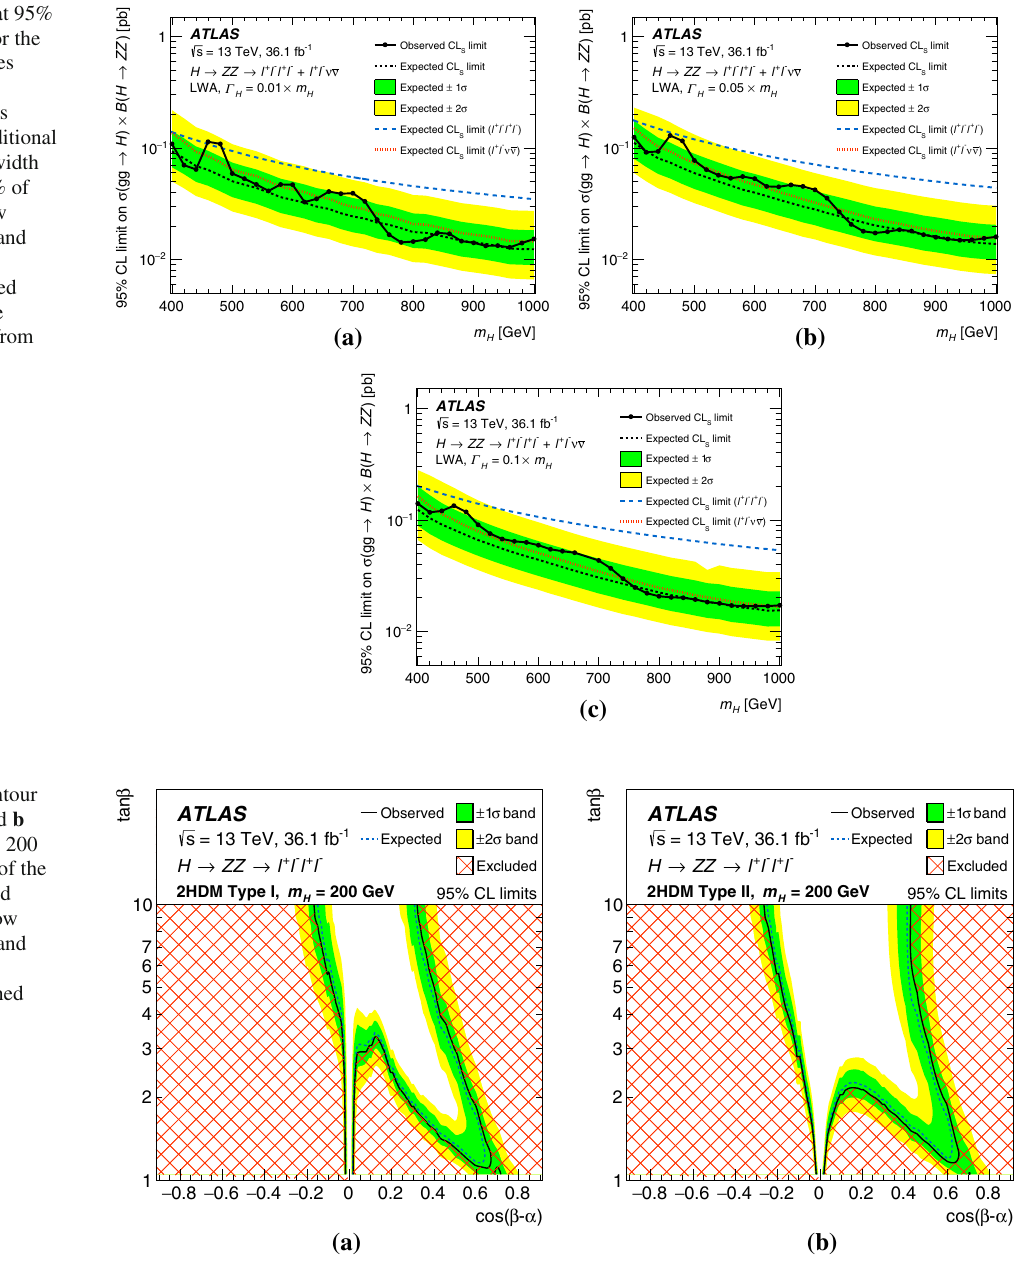
Fig. 8 The exclusion contour in the 2HDM a Type-I and b Type-II models for m H = 200 GeV shown as a function of the parameters cos (β − α) and tan β . The green and yellow bands represent the ± 1 σ and ± 2 σ uncertainties in the expected limits. The hatched area shows the observed